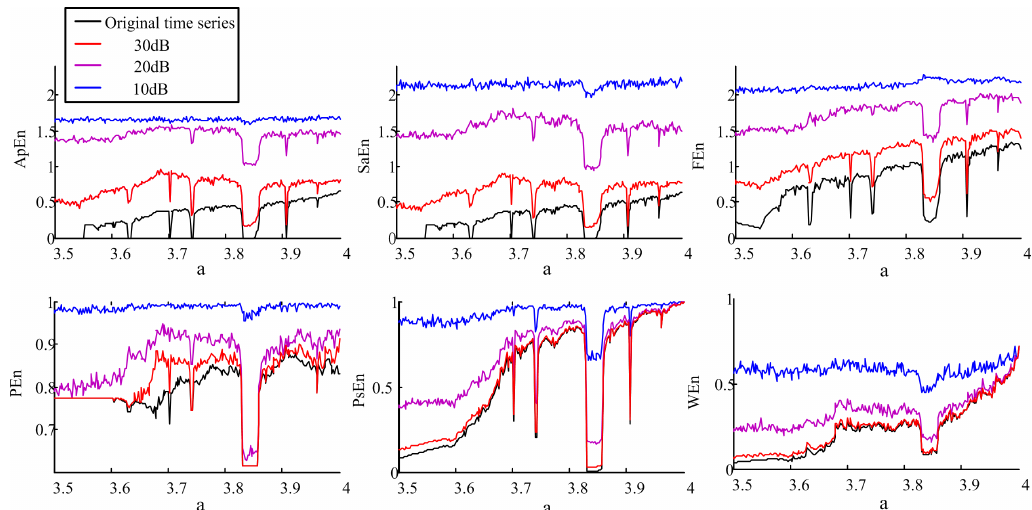
Table 2. Correlation coe±cients between each entropy and the maximal Lyapunov exponent ( p < 0 : 01). Original signal